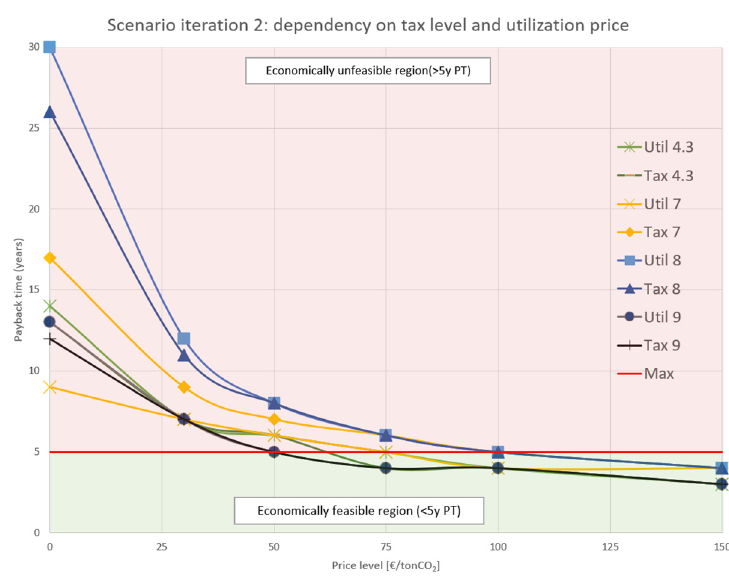
Figure 5. Results second iteration: scenario 7, 8 and 9.